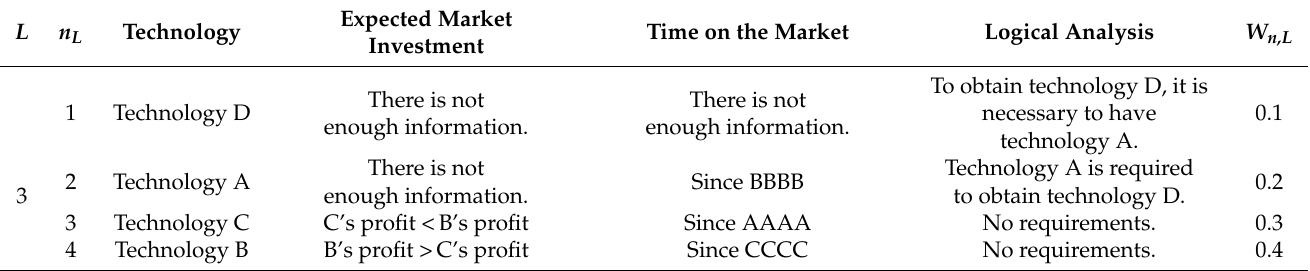
Table 4. Generic example of the assignment of n values with the respective W n,L calculated value.